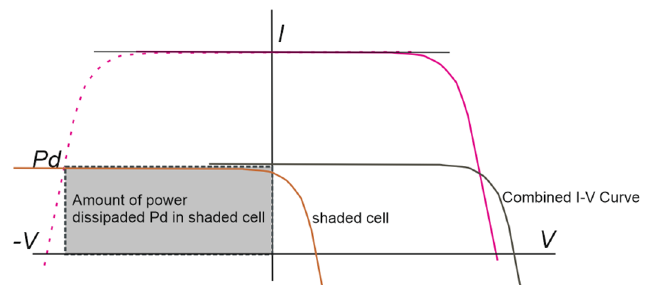
Figure 2. I–V characteristic curve of shading of a cell.